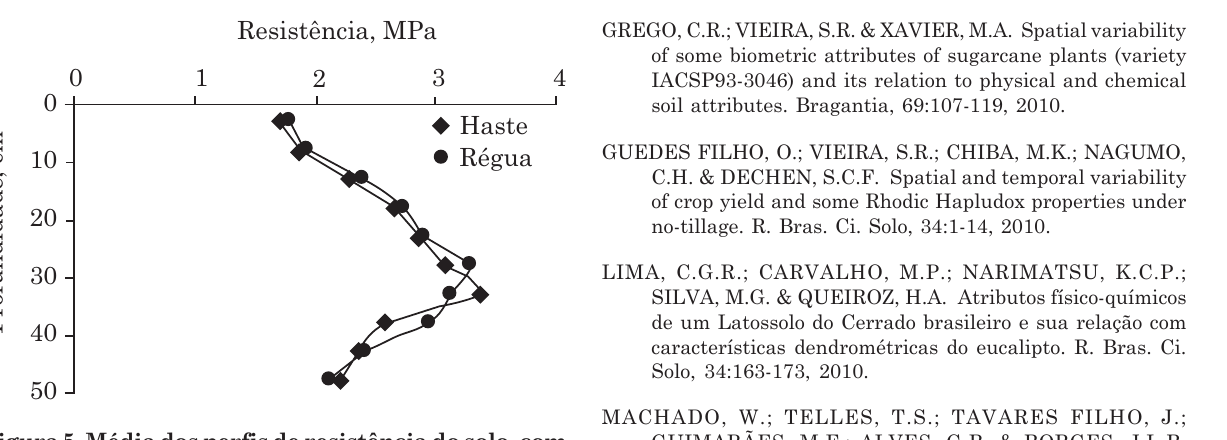
Figura 5. Média dos perfis de resistência do solo, com leitura na haste e na